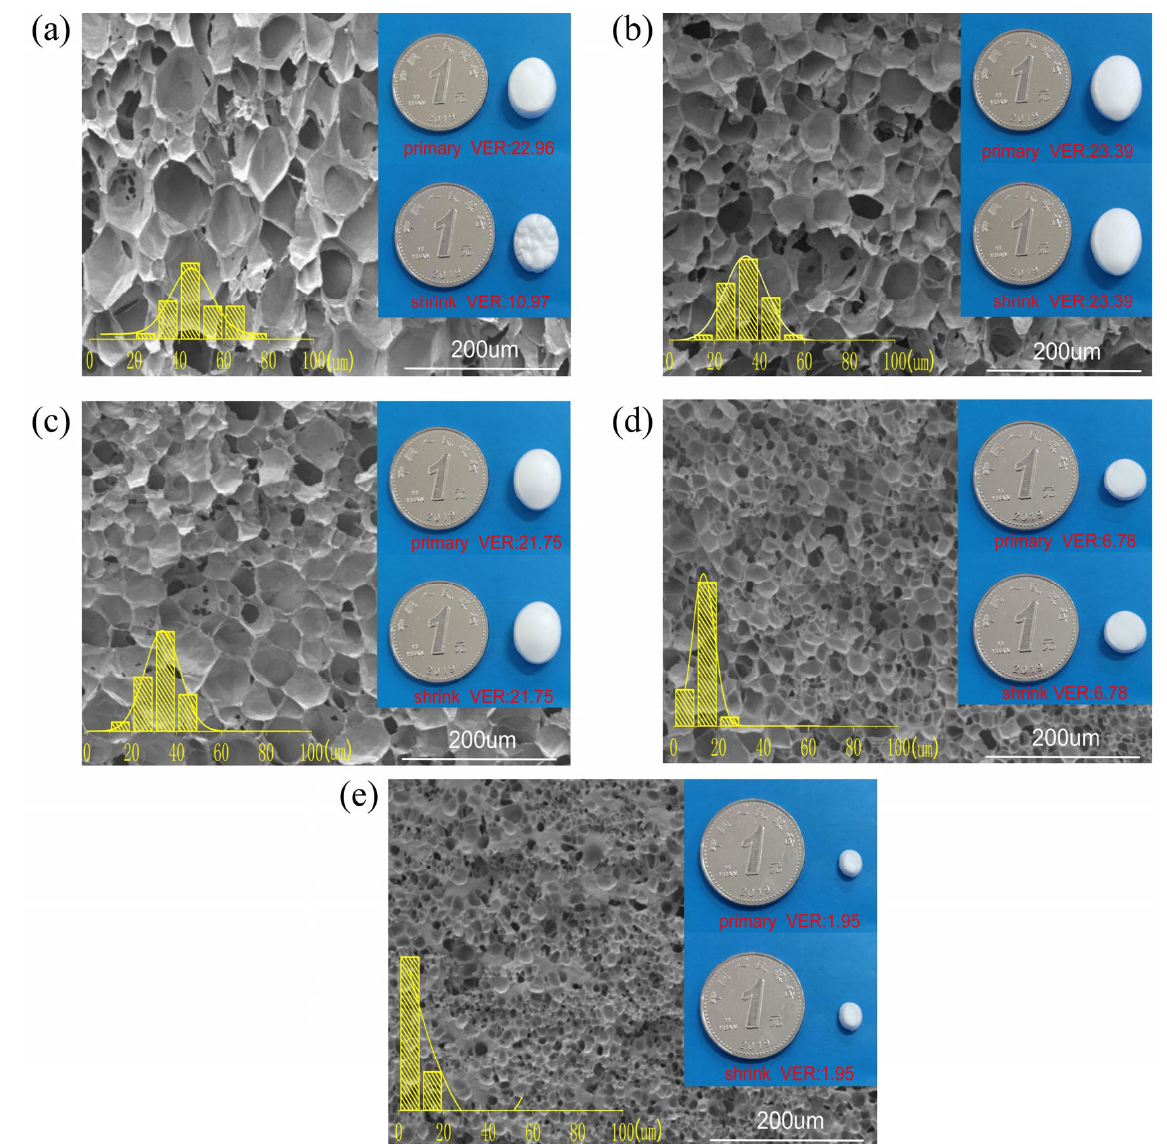
Figure 7. Distribution of cell morphology and cell size of PPCE ‐ 1.2 samples under different gas